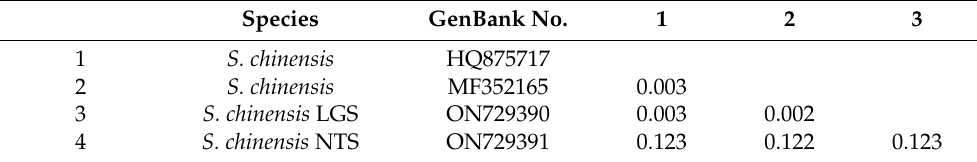
Table 2. The genetic distance of four mt genomes within Siphlonuridae. Species GenBank No.